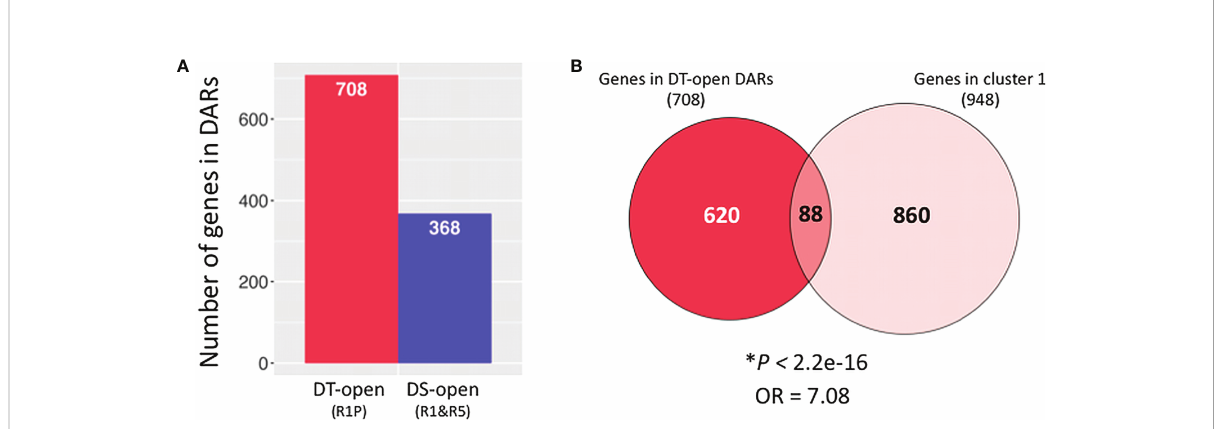
FIGURE 5 Identi fi cation of genes in differentially accessible chromatin regions (DARs) between DT and DS germinating radicles. (A) Number of genes (1 Kb promoter + mRNA) present in DARs between DS (R1&R5) and DT (R1P) samples (adjusted P < 0.05; Benjamini – Hochberg method). (B) Venn diagrams show overlaps between genes in DT-DARs detected by ATAC-seq and genes belonging to cluster 1 detected by RNA-seq. Asterisks indicate signi fi cant overlap ( P values from Fisher ’ s exact test; OR: odds ratio which represents the strength of association, with OR>1 corresponding to a strong